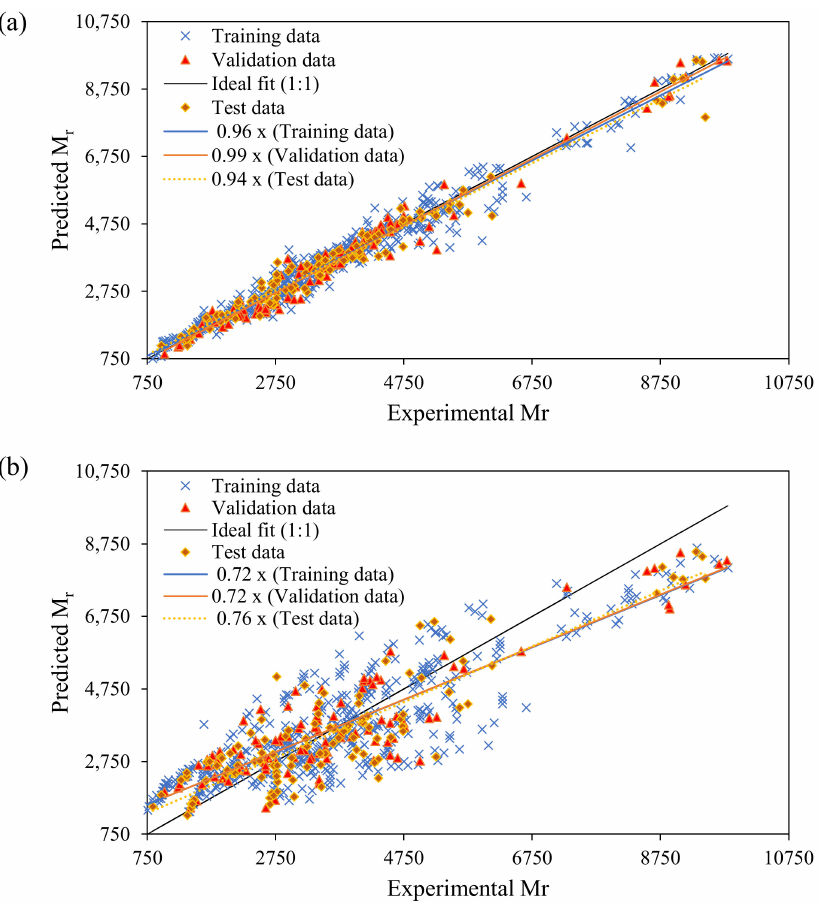
Figure 3. Comparison of experimental and predicted results: ( a ) ANN; ( b )